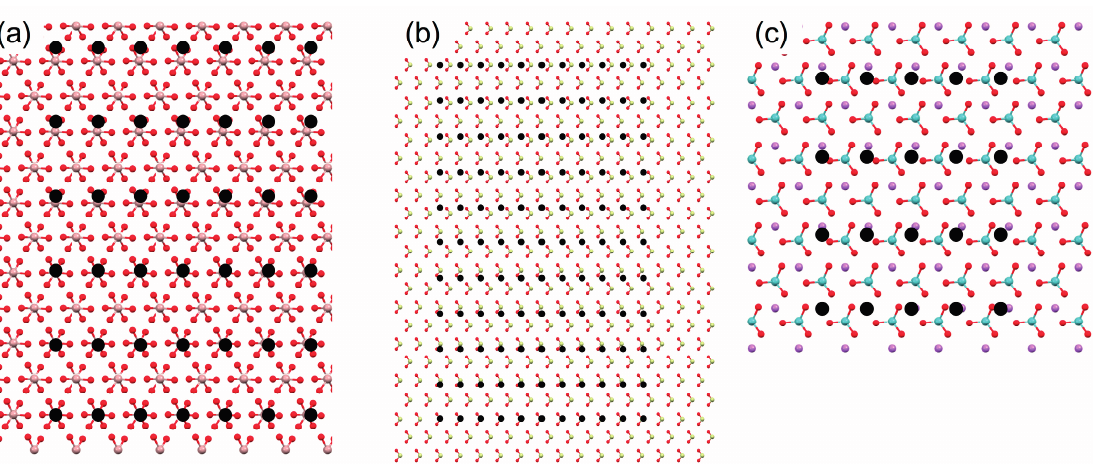
Figure 4. Molecular models to show the maximum supercell dimensions of aragonite (0 0 1) that generated the dimensionless potential ( V / V o ) less than 0.5 with the (0 0 1) planes of the substrates: ( a ) Al 2 O 3 ; ( b ) SiO 2 ; and ( c ) LiNbO 3 . The filled black circles are the lattice points of aragonite overlayer.